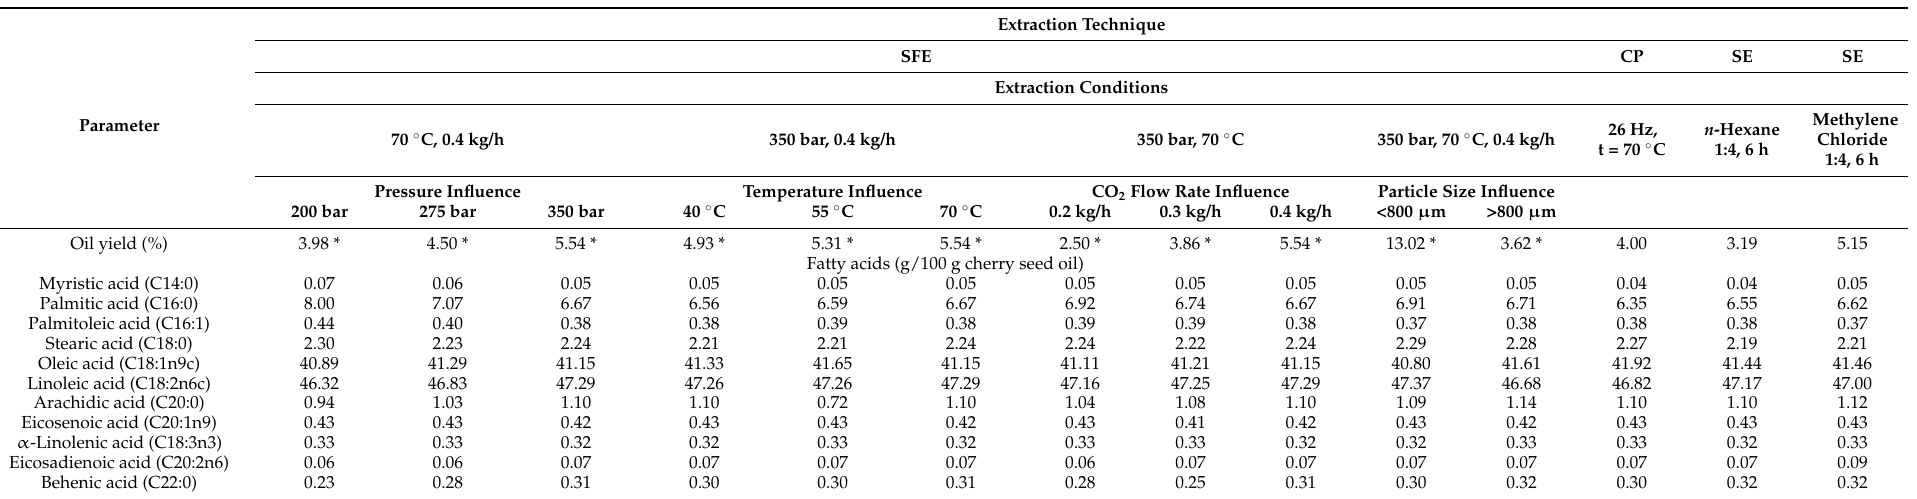
Table 2. Oil yield and fatty acid composition of cherry seed oils recovered by different extraction